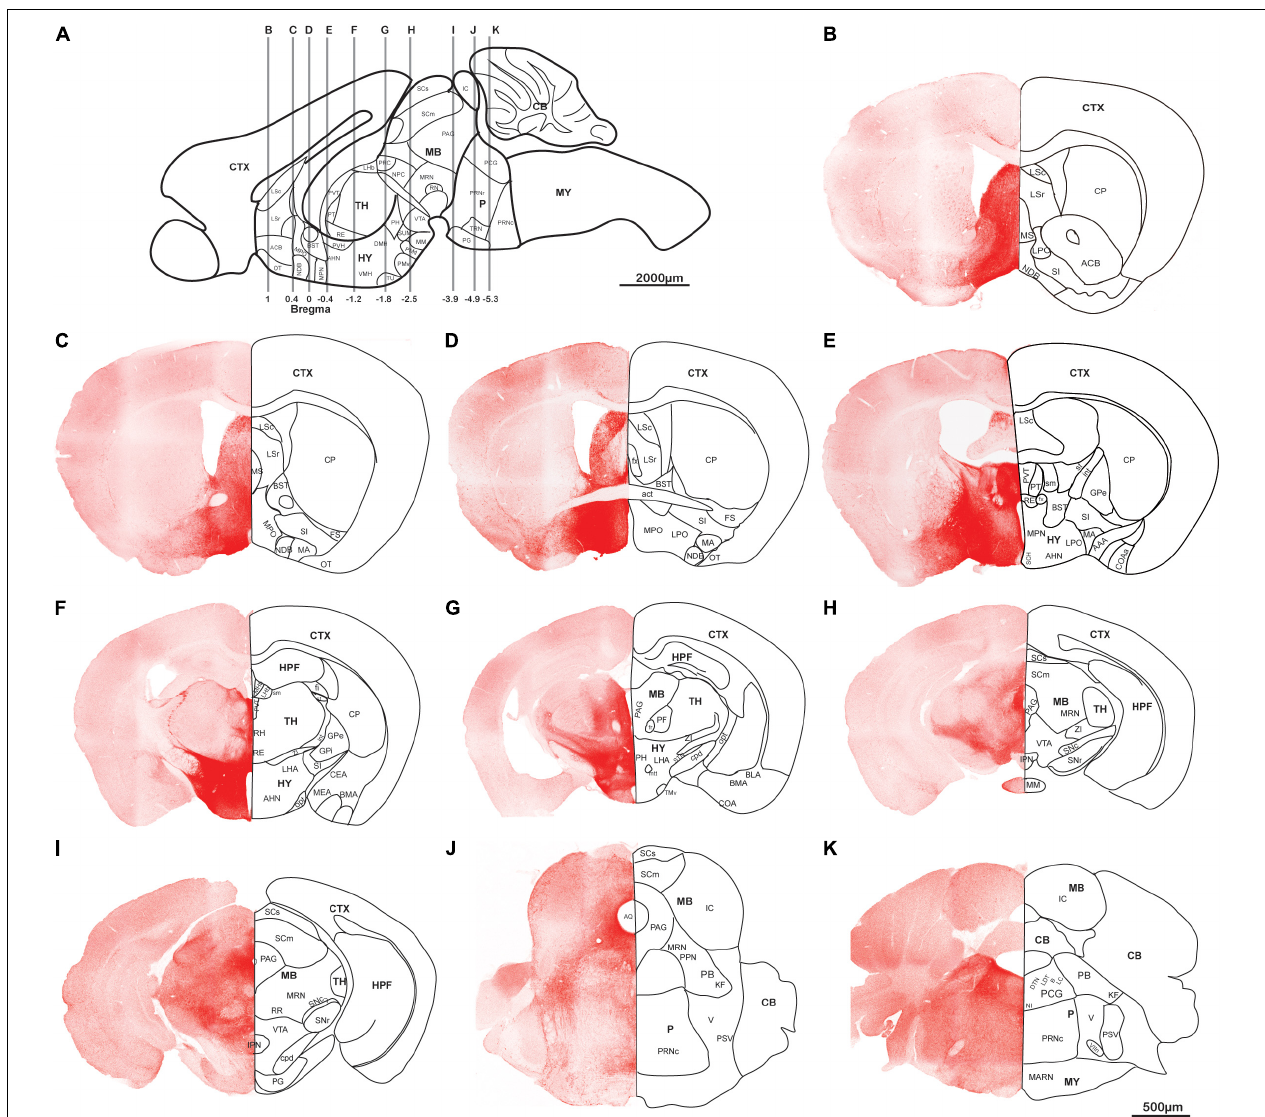
FIGURE 3 | Orexin projections in coronal planes. Orexin-Cre mice were injected with AAV5-DIO-ChrimsonR-tdT into LHA. (A) Schematic diagram showing the anterior-posterior positions of the coronal brain slices. (B–K) Representative confocal images showing the orexin projections in coronal planes. Scale bars: 500 µ m. AAA, anterior amygdalar area; act, anterior commissure, temporal limb; AHN, anterior hypothalamic nucleus; ACB, nucleus accumbens; AQ, cerebral aqueduct; B, barrington’s nucleus; BLA, basolateral amygdalar nucleus; BMA, basomedial amygdalar nucleus; BST, bed nuclei of the stria terminalis; CB, cerebellum; CEA, central amygdalar nucleus; COA, cortical amygdalar area; COAa, cortical amygdalar area, anterior part; CP, caudoputamen; cpd, cerebal peduncle; CTX, cerebral cortex; DMH, dorsomedial nucleus of the hypothalamus; DTN, dorsal tegmental nucleus; fi, fimbria; fr, fasciculus retroflexus; fx, columns of the fornix; FS, fundus of striatum; GPe, globus pallidus, external segment; GPi, globus pallidus, internal segment; HPF, hippocampal formation; HY, hypothalamus; int, internal capsule; IC, inferior colliculus; IPN, interpeduncular nucleus; KF, Koelliker-Fuse subnucleus; LC, locus coeruleus; LDT, laterodorsal tegmental nucleus; LHA, lateral hypothalamic area; LHb, lateral habenula; LPO, lateral preoptic area; LSc, lateral septal nucleus, caudodorsal part; LSr, lateral septal nucleus, rostroventral part; mtt, mammillothalamic tract; MA, magnocellular nucleus; MARN, magnocellular reticular nucleus; MB, midbrain; MEA, medial amygdalar nucleus; MHb, medial habenula; MM, medial mammillary nucleus; MPN, medial preoptic nucleus; MPO, medial preoptic area; MRN, midbrain reticular nucleus; MS, medial septal nucleus; MY, medulla; NI, nucleus incertus; NDB, diagonal band; NPC, nucleus of the posterior commissure; opt, optic tract; OT, olfactory tubercle; P, pons; PAG, periaqueductal gray; PB, parabrachial nucleus; PCG, pontine central gray; PF, parafascicular nucleus; PG, pontine gray; PH, posterior hypothalamic nucleus; PMd, dorsal premammillary nucleus; PMv, ventral premammillary nucleus; PPN, pedunculopontine nucleus; PRC, precommissural nucleus; PRNr, pontine reticular nucleus; PRNc, pontine reticular nucleus, caudal part; PSV, principal sensory nucleus of the trigeminal; PT, parataenial nucleus; PVT, paraventricular nucleus of the thalamus; PVH, paraventricular hypothalamic nucleus; RE, nucleus of reunions; RH, rhomboid nucleus; RN, red nucleus; RR, midbrain reticular nucleus, retrorubral area; sm, stria medullaris; st, stria terminalis; SCH, suprachiasmatic nucleus; SCm, superior colliculus, motor related; SCs, superior colliculus, sensory related; SI, substantia innominata; STN, subthalamic nucleus; SNc, substantia nigra, compact part; SNr, substantia nigra, reticular part; SUM, supramammillary nucleus; TH, thalamus; TMv, tuberomammillary nucleus, ventral part; TRN, tegmental reticular nucleus; TU, tuberal nucleus; V, motor nucleus of trigeminal; VIIn, facial nerve; VMH, ventromedial hypothalamic nucleus; VTA, ventral tegmental area; ZI, zona incerta.